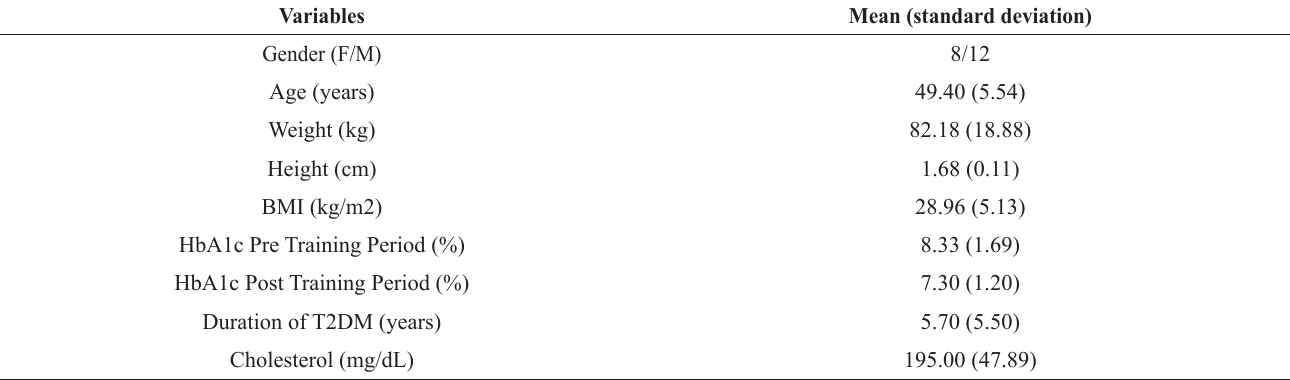
Table 1. Demographical and clinical characteristics for individuals with type 2 diabetes mellitus (T2DM) at baseline. Variables